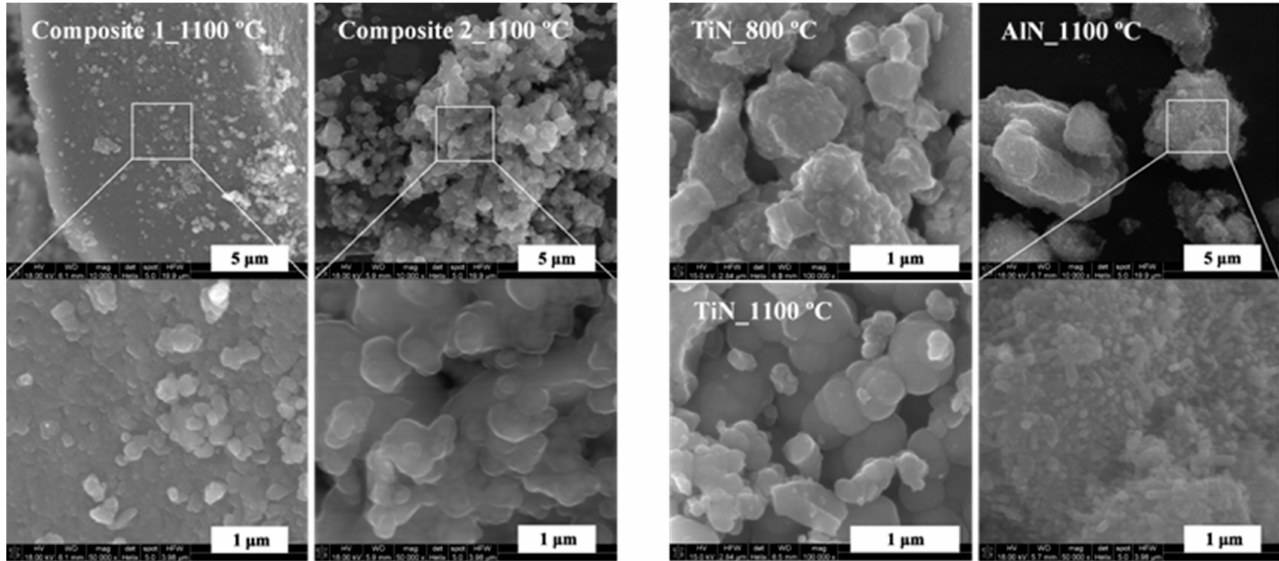
Figure 5. SEM images of selected nanopowders for composite ( left panel ) and individual nitrides ( right panel ). Note that areas in the white-edge rectangles are magnified by factor of 5 and shown in adjoining